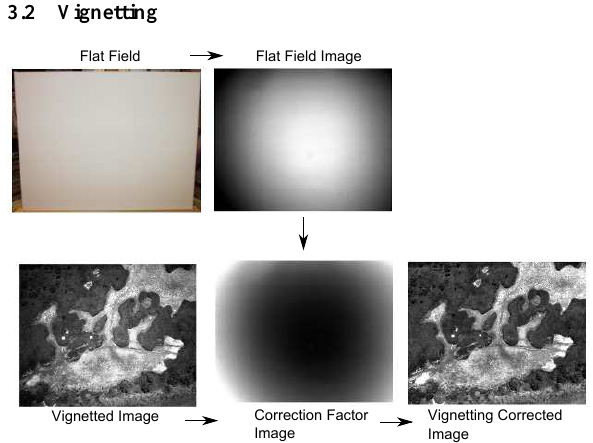
Figure 6: Illustration of the Generation of Flat Field derived Cor- rections Factor Images, and their application to imagery (Chan- nel: 3)